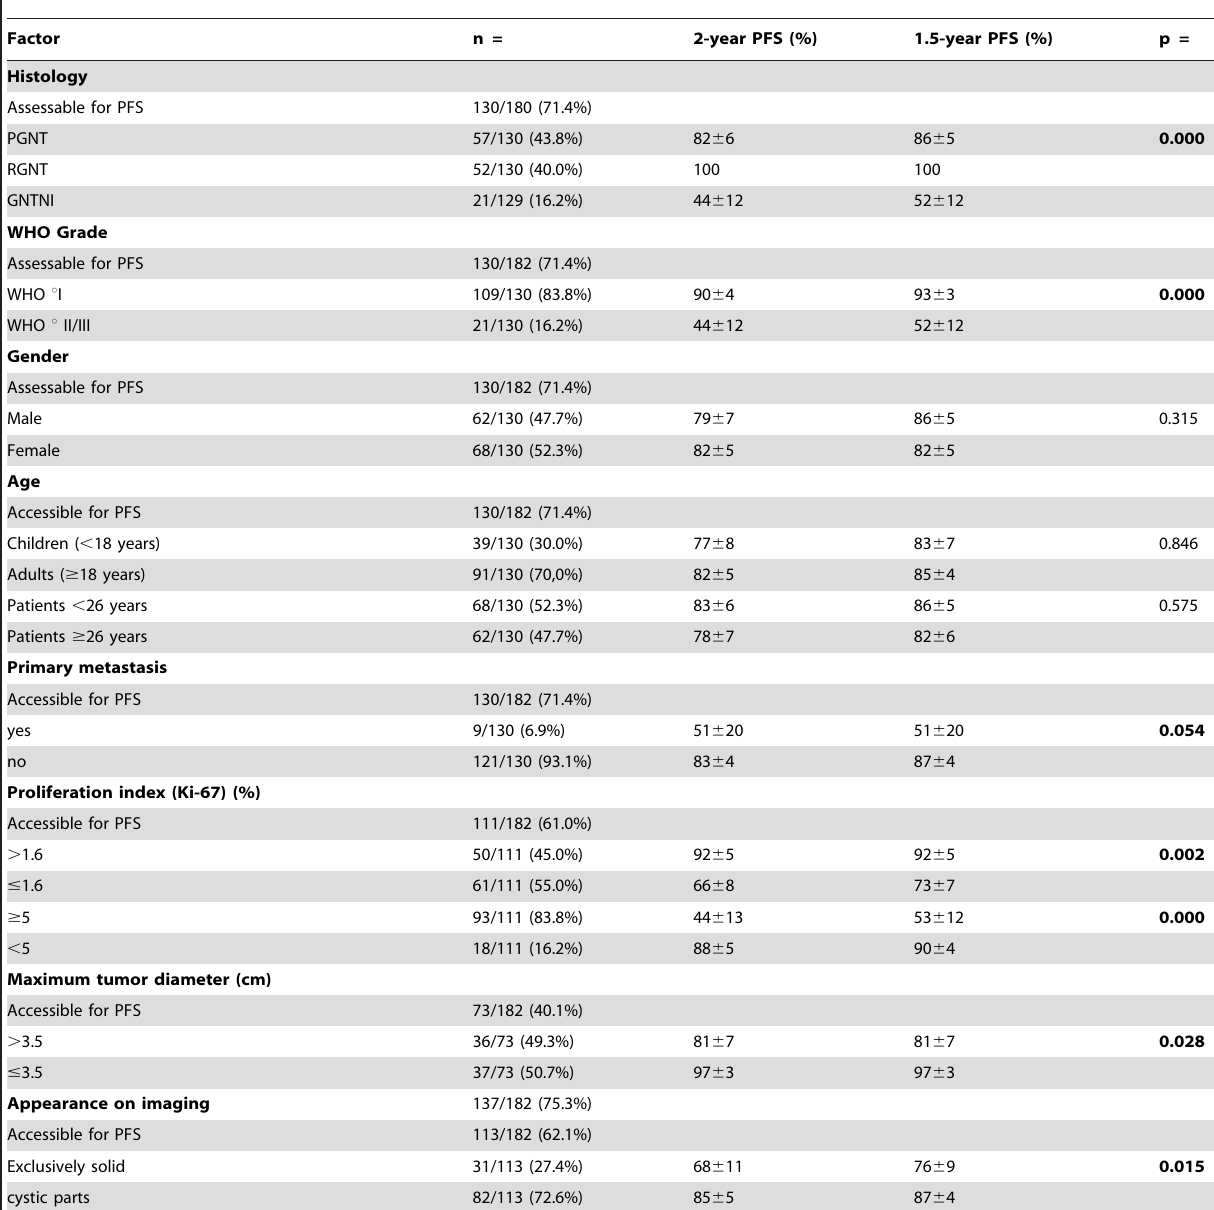
Table 4. Impact of potential prognostic factors on